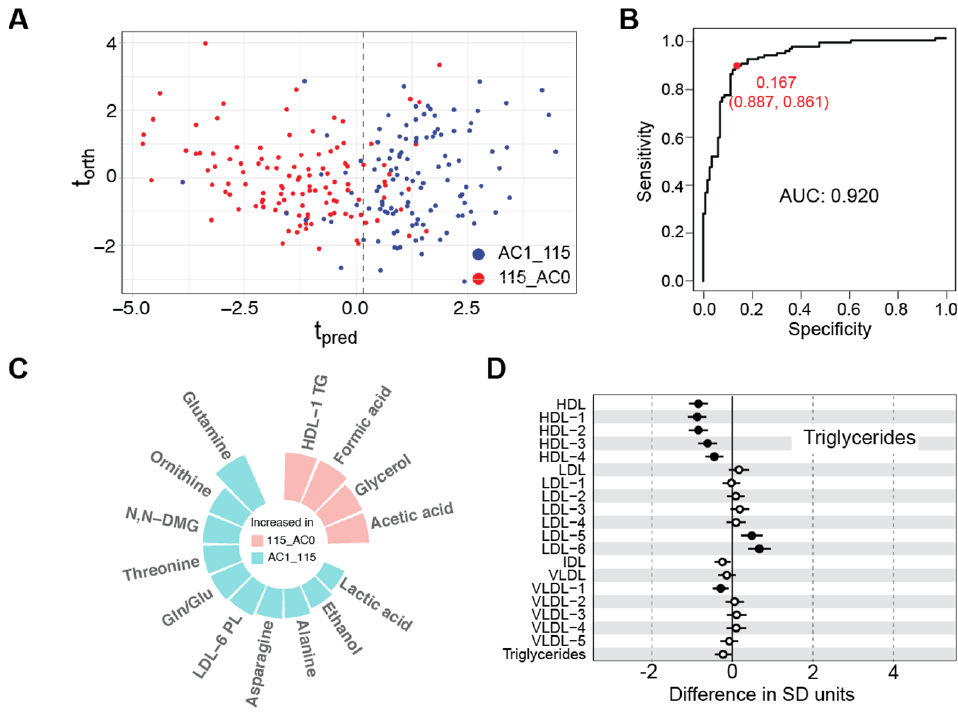
Figure 4. ( A ) O-PLS-DA score plot representation for the discrimination between the first 115 samples collected during 2020 (115_AC0, red circles) and the last 115 samples collected during 2021 (AC1_115, blue circles). ( B ) Receiver operating characteristic curve for the O-PLS-DA model shown in Figure 2A. The area under the curve (AUC) is 0.92 In red is indicated the t pred value that maximizes Youden’s index and the resulting specificity and sensitivity between parentheses. ( C ) Circular bar plot with the 14 metabolic parameters used for the discrimination model. The bars are proportional to the weight in the discrimination. ( D ) Triglyceride variation between 115_AC0 and AC1_115.